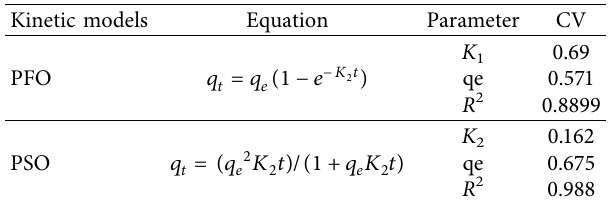
Figure 14: (a) Pseudo-frst-order and (b) pseudo-second-order kinetic models for fuoride ion adsorption on HAp NPs. Table 4: Nonlinear kinetic model equation and calculated parameter